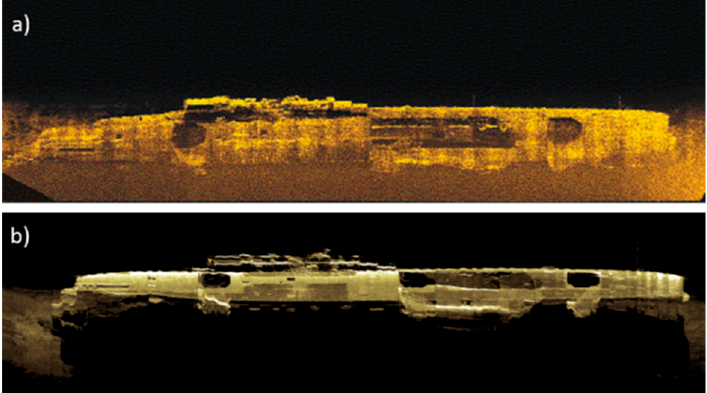
Figure 17. Sonograms acquired with a towed side-scan sonar DF-1000: ( a ) using operational parameters R = 100 m; Fa = 50 m; D = 50 m; ( b ) using operational parameters R = 100 m; Fa = 40 m; D = 30 m.